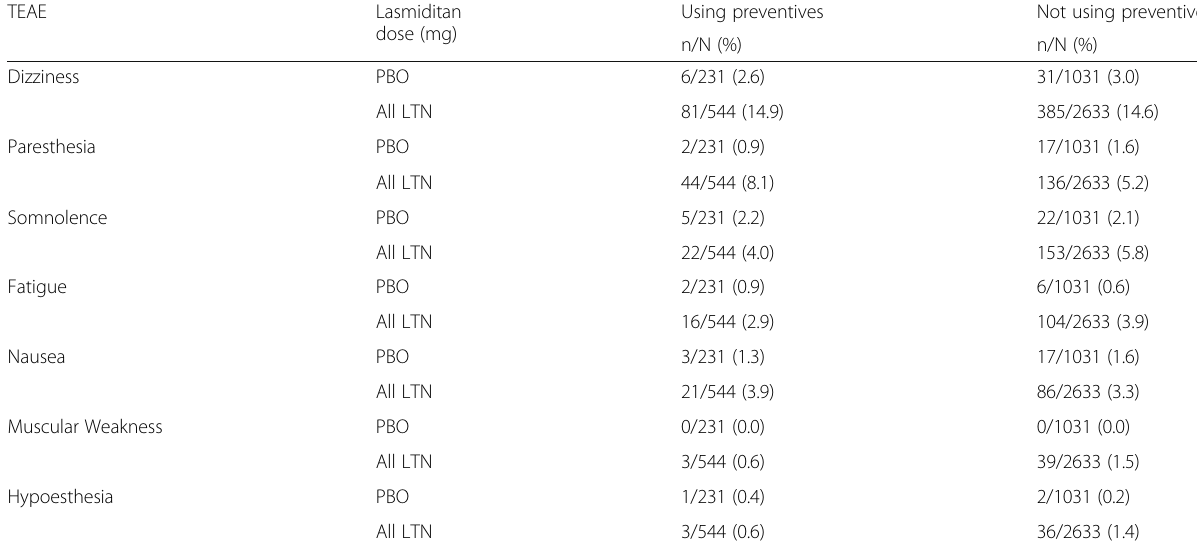
Table 6 Treatment-emergent adverse events occurred at similar rates in patients using and not using migraine preventive